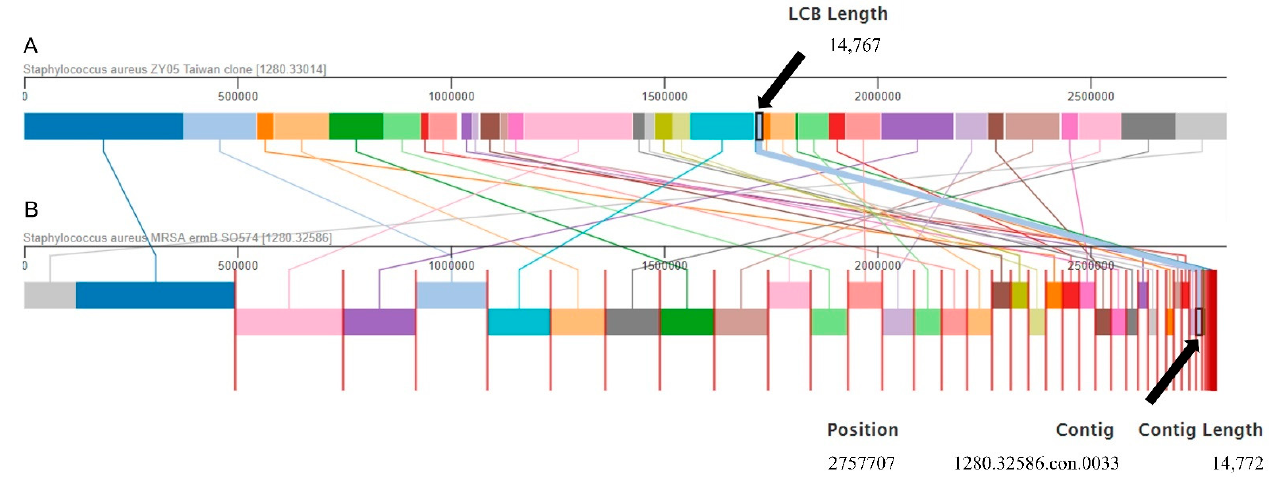
Figure 2. Visualization of global large-scale genome alignment according to progressive Mauve algorithm for genomes of CA-MRSA ZY05 and CA-MRSA SO574/12 strains. Each type of locally collinear block (LCB), is marked with a different color. The pair of LCBs contain the high conserved homology regions are assigned with the same stain. The homology regions that were defined within the aligned genomes are connected with the line in the same color. Both the contig 33 in genome of CA-MRSA SO574/12 isolate, which contains erm B gene, and its matching pair LCB in genome of CA-MRSA ZY05 strain are marked on the diagram in light blue.